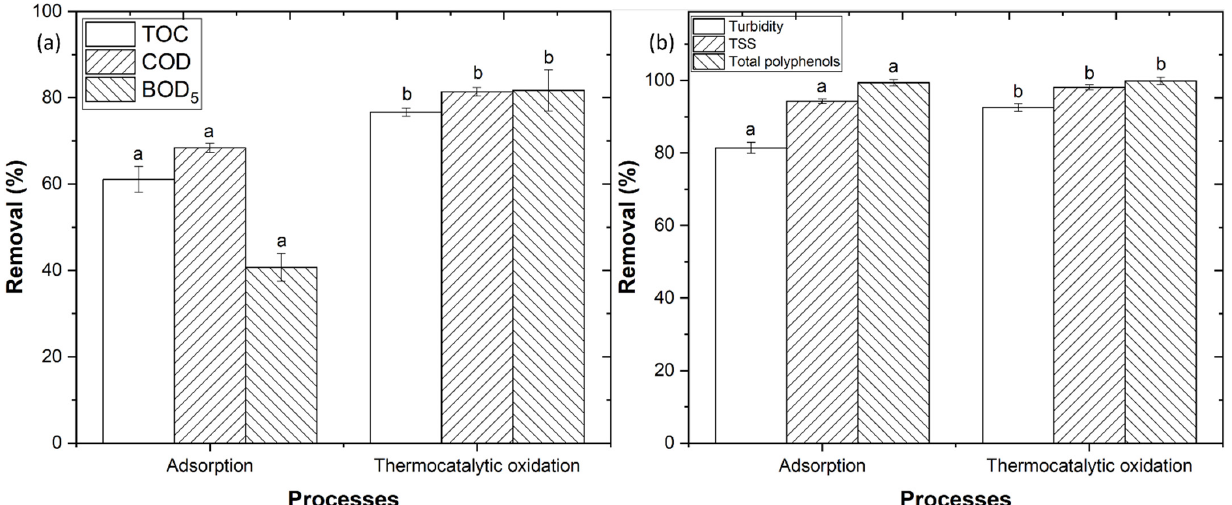
Figure 9. Overall results after adsorption process and thermocatalytic oxidation processes in ( a